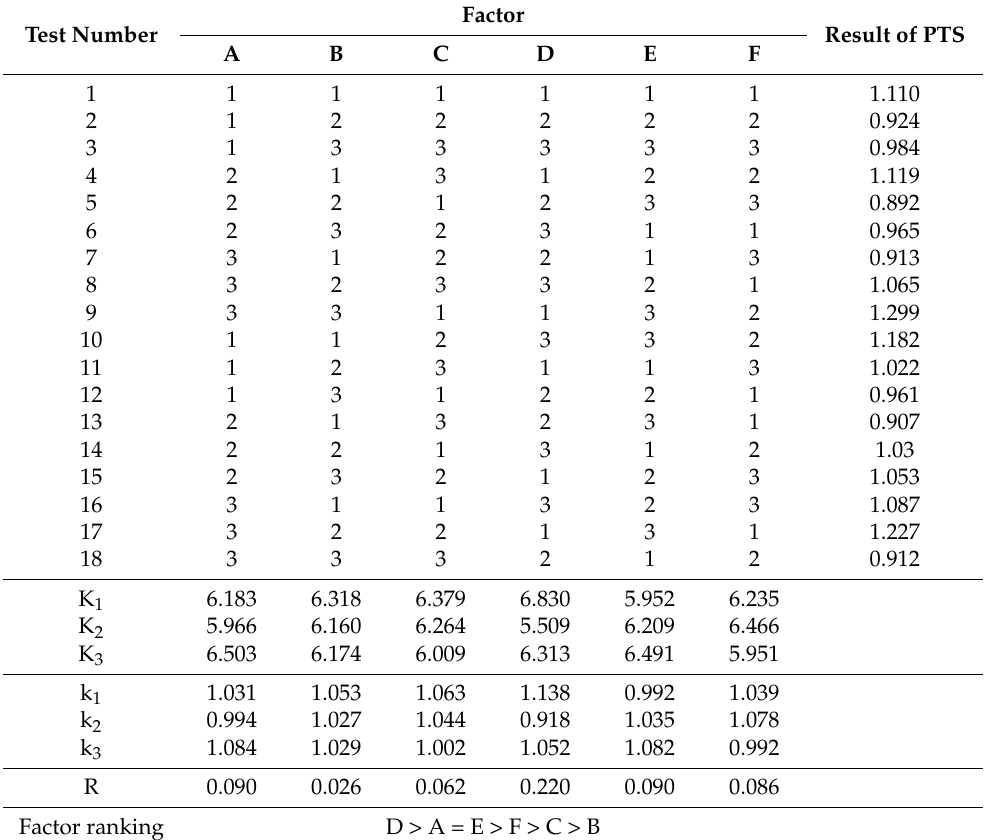
Table 5. Results and range analysis of the orthogonal